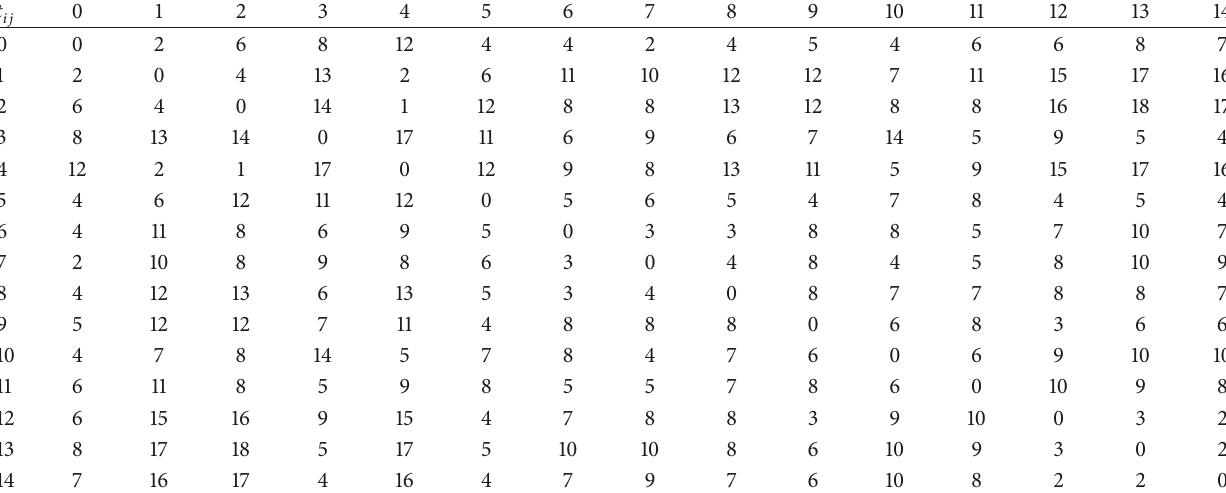
Table 6: 14-node travel time matrix for each point (unit: